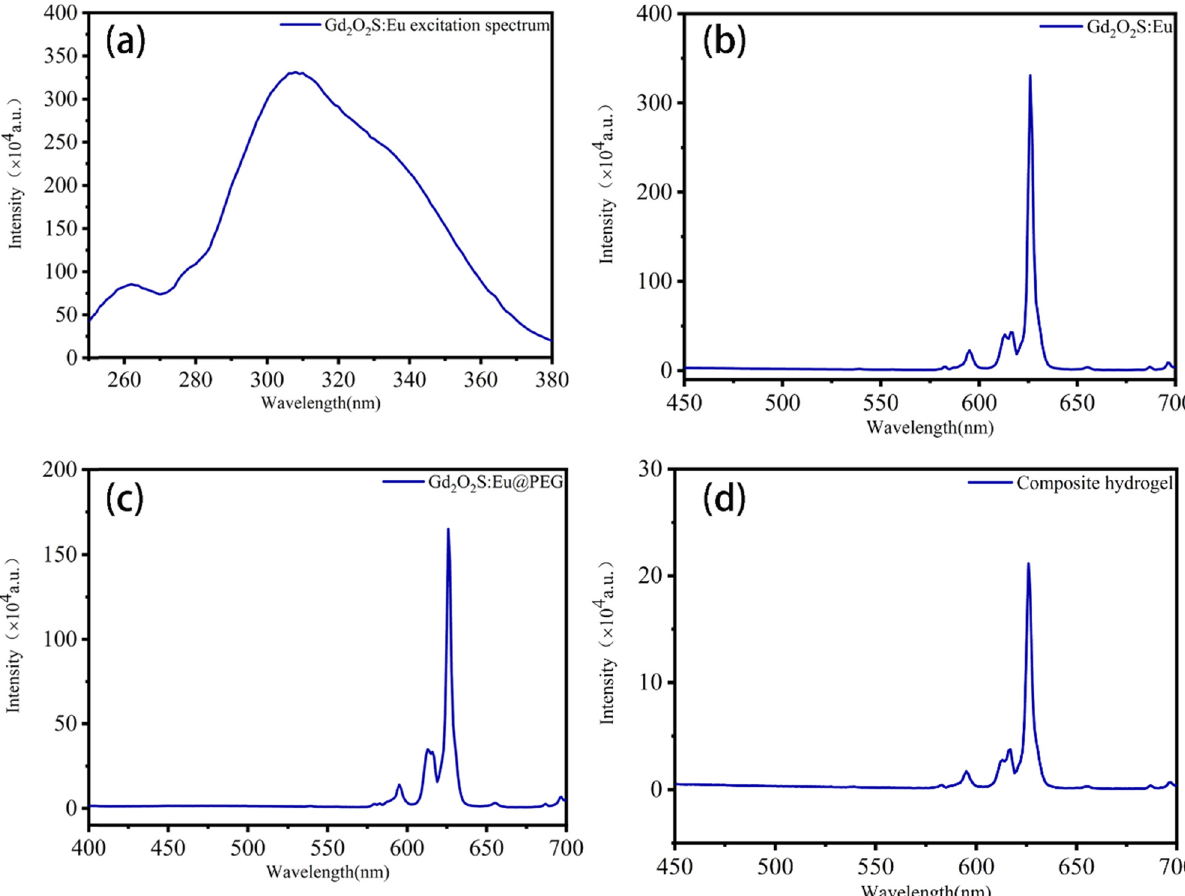
Figure 6: ( a ) Excitation spectra of Gd 2 O 2 S:Eu. ( b – d ) Emission spectra of Gd 2 O 2 S:Eu, Gd 2 O 2 S:Eu@PEG, and the composite gel ( λ ex = 310 nm )